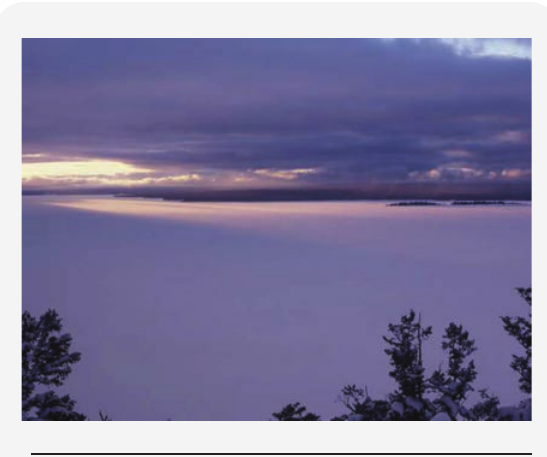
Figure 12. Yellowstone Lake in winter. Organic compounds could accumulate in similar lakes and ponds on the early earth, and proximity to the atmosphere along with exposure to UV light could have supplied sources of chemical energy. Cool water is good for a delicate molecule such as RNA, but hydrothermal events in the lake emit streams of hot water, which could provide transient exposure to the high temperatures needed for strand separation following template copying.